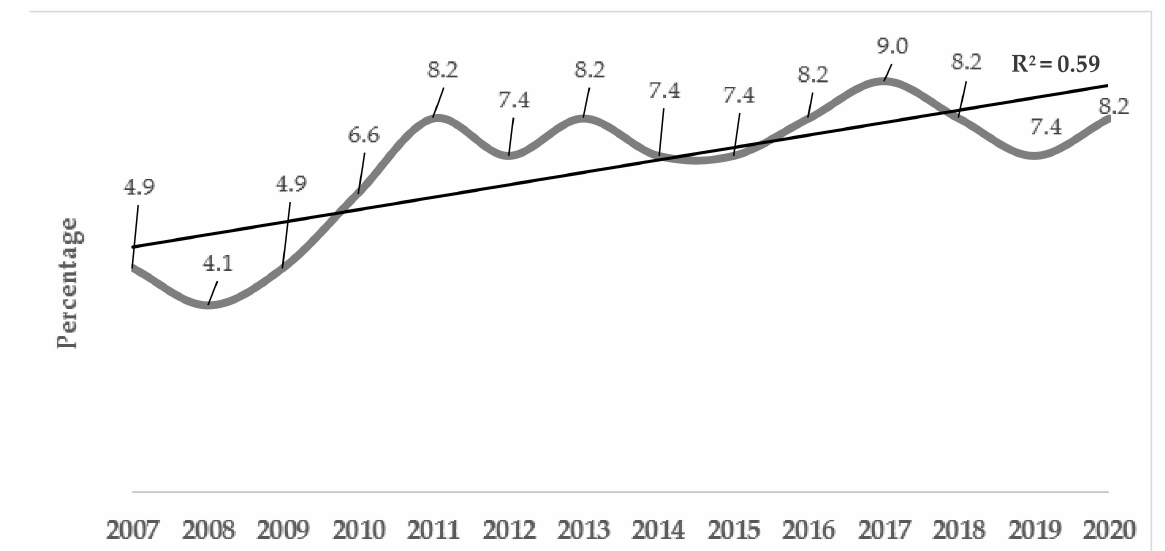
Figure 2. Temporal evolution of articles published between 1 January 2007 and 1 December